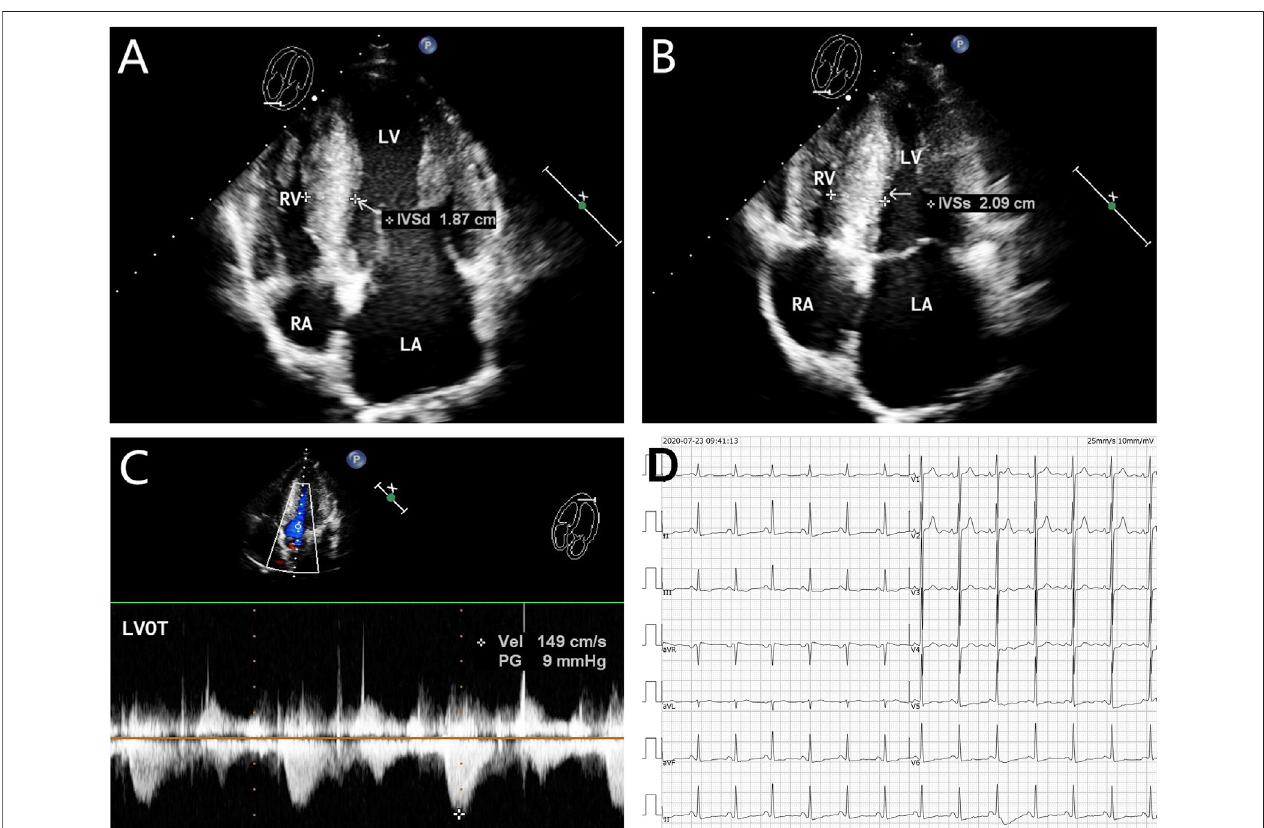
FIGURE3| Echocardiographyandelectrocardiographyintheproband ’ smother( II-2 ). (A – C) EchocardiographyandcolorDopplershowedenlargementoftheleft atrium, thickening of the interventricular septum at the end-diastole, and no out fl ow obstruction, EF 62%. (D) ECG showed that inferior and high lateral wall leads to ST- segment depression, T-wave low fl at, or T-wave